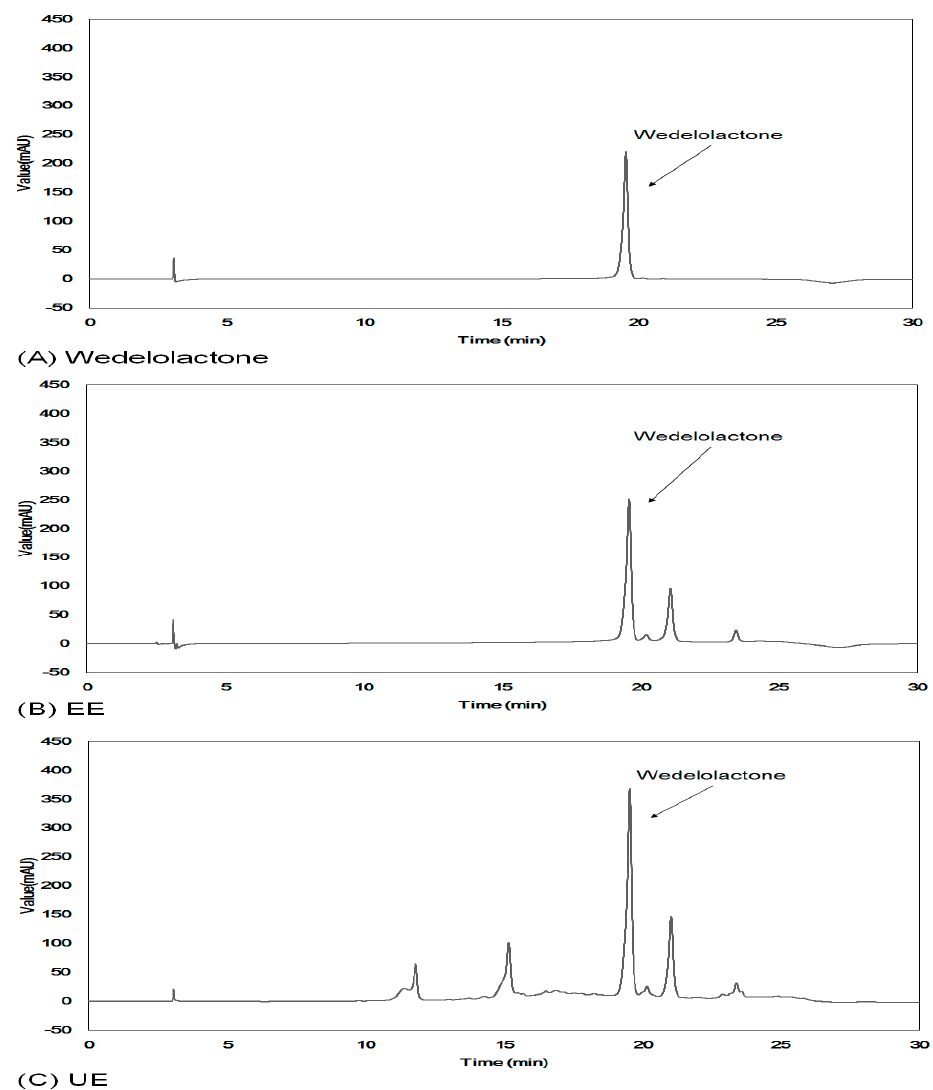
Figure 2. Comparison of High Performance Liquid Chromatography (HPLC) chromatograms of E. prostrata L. extracts from two different extraction processes. ( A ): Wedelolactone, a standard, ( B ) EE: 70% ethanol extraction at 80 °C, ( C ) UE: ultrasonic extraction with 70% ethanol at 40 °C.